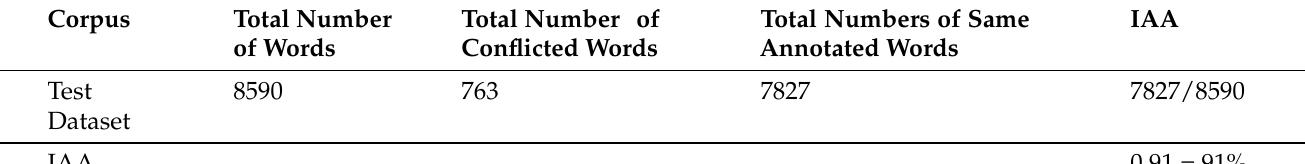
Table 5. Detailed statistics of IAA for the test